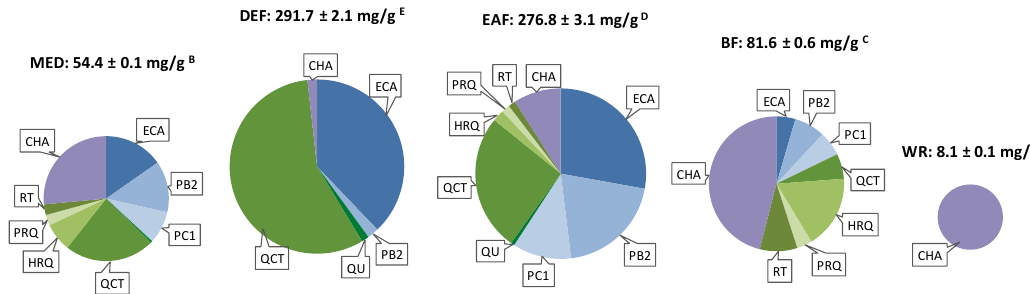
Figure 2. Total contents per g of dry weight of the S. domestica leaf extracts (LC-PDA-peaks; means ± SD, n = 3) and the relative proportions of the activity markers according to Matczak et al. [3]. The different letters A–E indicate significant differences ( p < 0.05). MED, methanol-water (7:3, v/v) extract; DEF, diethyl ether fraction; EAF, ethyl acetate fraction; BF, n -butanol fraction; WR, water residue. For compound codes and structures, see Figure 1.